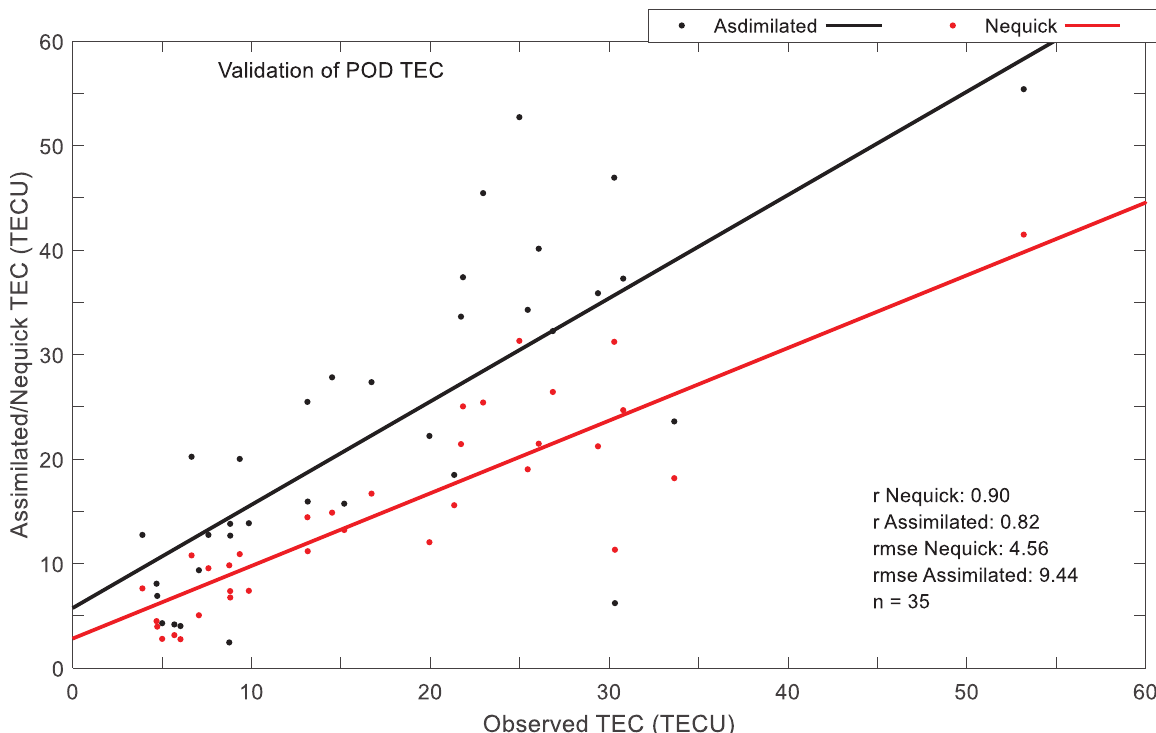
Figure 10. Scatter plot of TEC obtained from NeQuick model and assimilation as a function of coincident observed TEC over GPS receiver stations at KGNI, TCMS, YONS, and BJFS. The data plotted are those on the days of the study